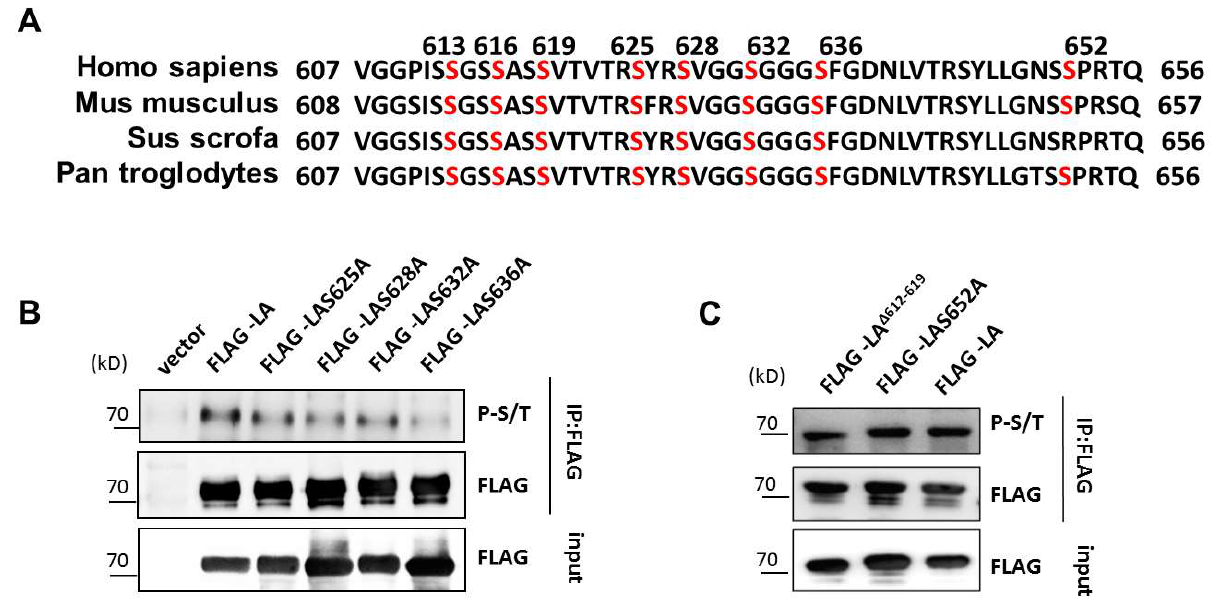
Figure 2. Influence of Ser628 and Ser636 on the phosphorylation level of lamin A. ( A ) Analysis of potential phosphorylation sites among the 50 C-terminal amino acids of the lamin A protein. ( B , C ) FLAG-lamin A and its mutants were expressed in HEK293 cells and immunoprecipitated using an anti-FLAG antibody; Western blot analysis of the phosphorylation levels of wild type lamin A and lamin A-containing mutated phosphorylation sites using antibodies specific for serine/threonine phosphorylation.